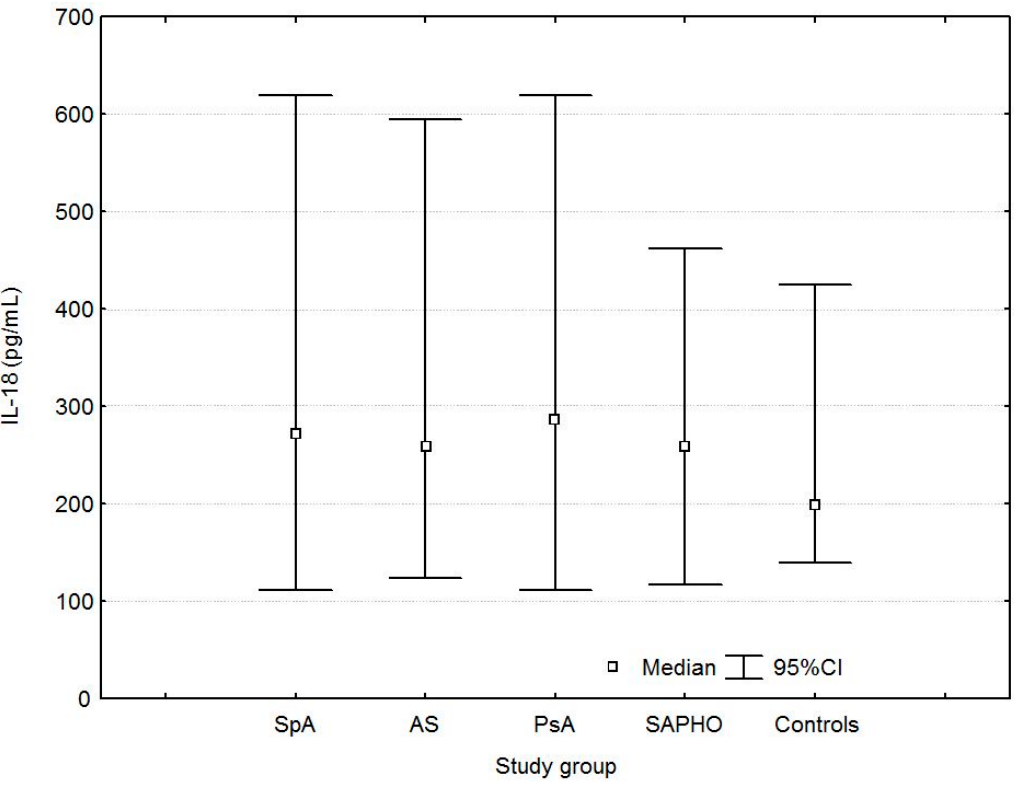
Figure 1. Serum concentrations of interleukin-18 (IL-18) in patients with spondyloarthritis (SpA), ankylosing spondylitis (AS), psoriatic arthritis (PsA), SAPHO syndrome (SAPHO), and controls.